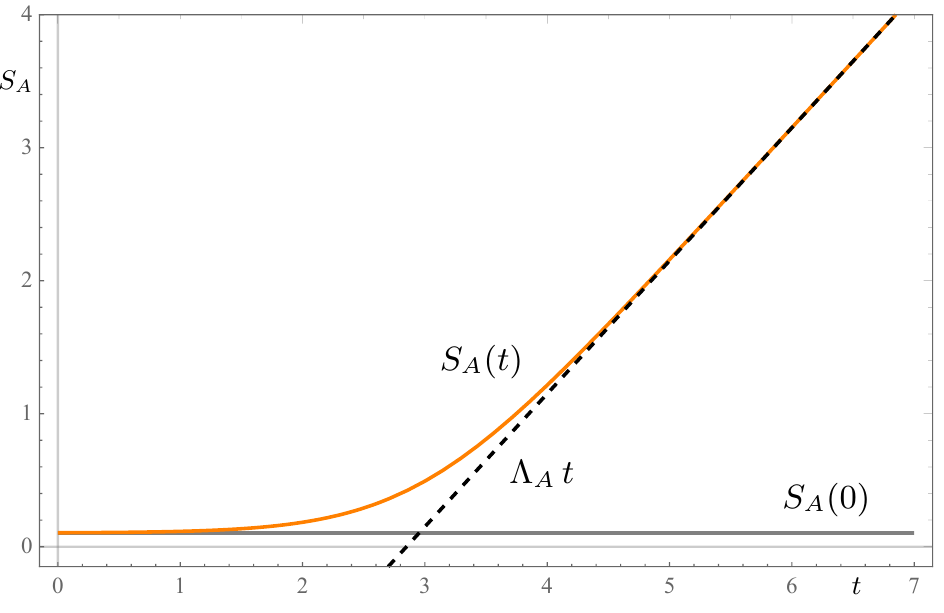
Figure 8 . Quantum (cid:12)eld in de Sitter space . We plot the entanglement entropy S A ( t ) = S ( (cid:23) ( t )) from (4.37) associated to the subsystem described in (4.36). In the phase of linear growth, the entropy is observed to grow with rate given by the Hubble rate H 0 as predicted by theorem 1. We set H 0 = 1 and R = 1 in this